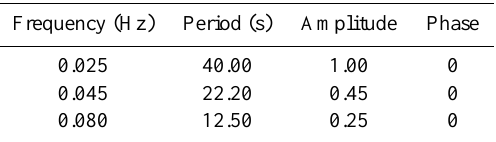
Table 1. Frequency and Amplitude values used to generate artifi- cially signal.